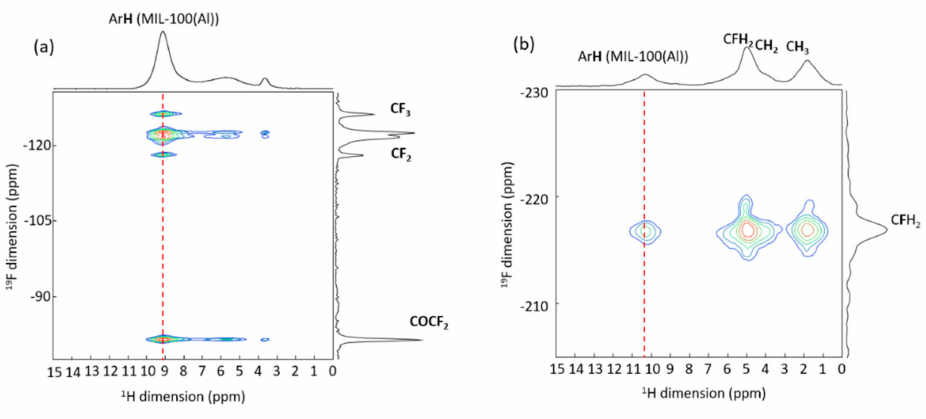
Figure 12. 19 F- 1 H 2D CPMAS NMR spectra of ( a ) FO@nanoMIL-100(Al) and ( b ) FP@nanoMIL-100(Al). The lines are assigned. The red dash line indicates the spatial proximity between the 19 F resonances and the 1 H of the MOF [37].